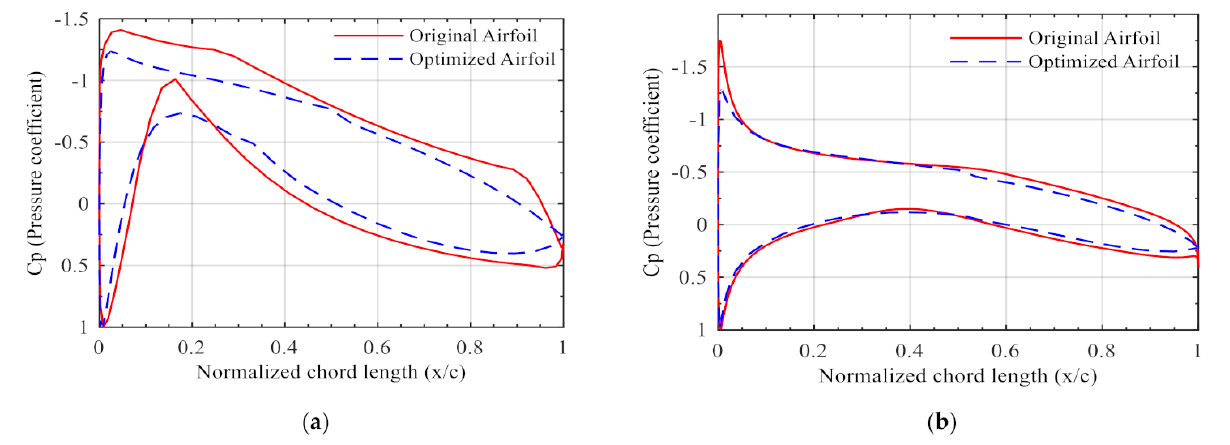
Figure 12. Distribution of pressure over the surface of an initial and optimized airfoil ( a ) NREL S-821; ( b )